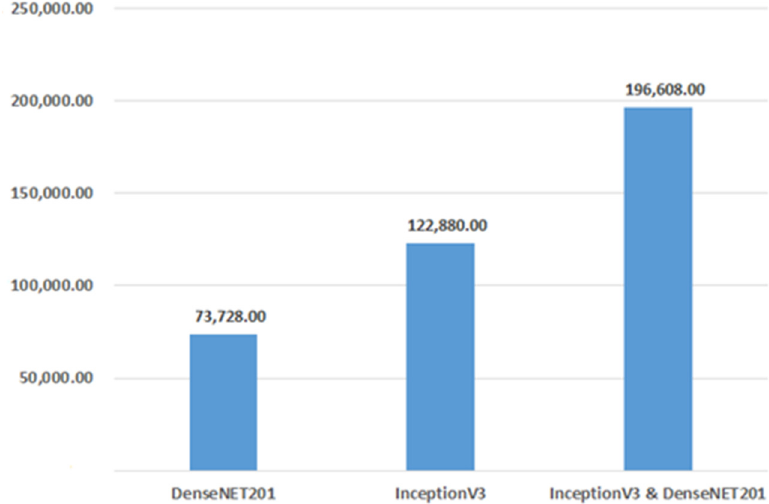
Figure 8. Number of features extracted using different pre-trained models.